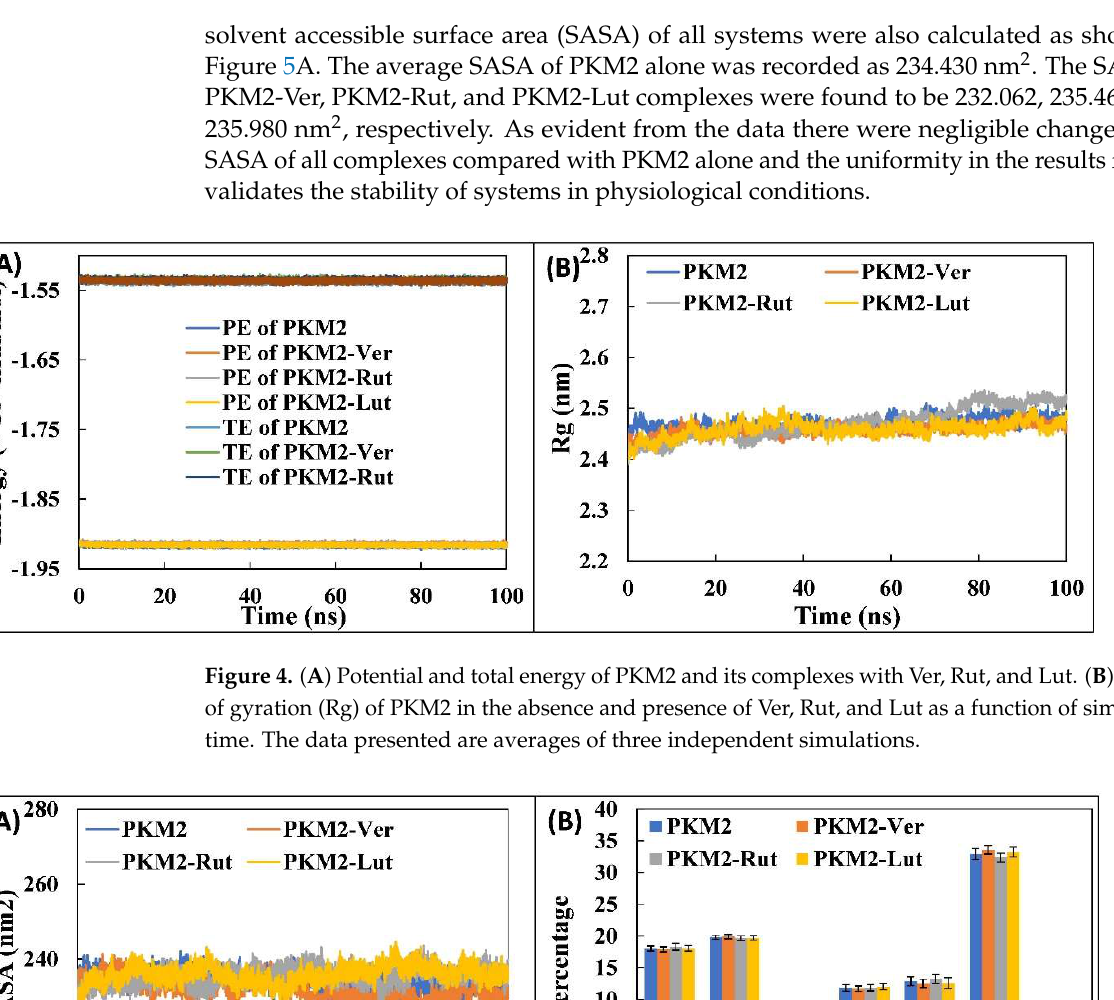
Figure 6. ( A ) Number of hydrogen bonds formed between PKM2-Ver, PKM2-Rut, and PKM2-Lut complexes over the entire course of simulation. The data presented are averages of three independ- ent simulations. ( B ) The hydrogen profile for the interaction of Lut with PKM2. ( C ) The hydrogen profile for the interaction of Rut with PKM2. ( D ) The hydrogen profile for the interaction of Ver with PKM2. Table 6. Binding free energy of ligands with PKM2 calculated by the MM-PBSA method for 100 snapshots of MD simulation.